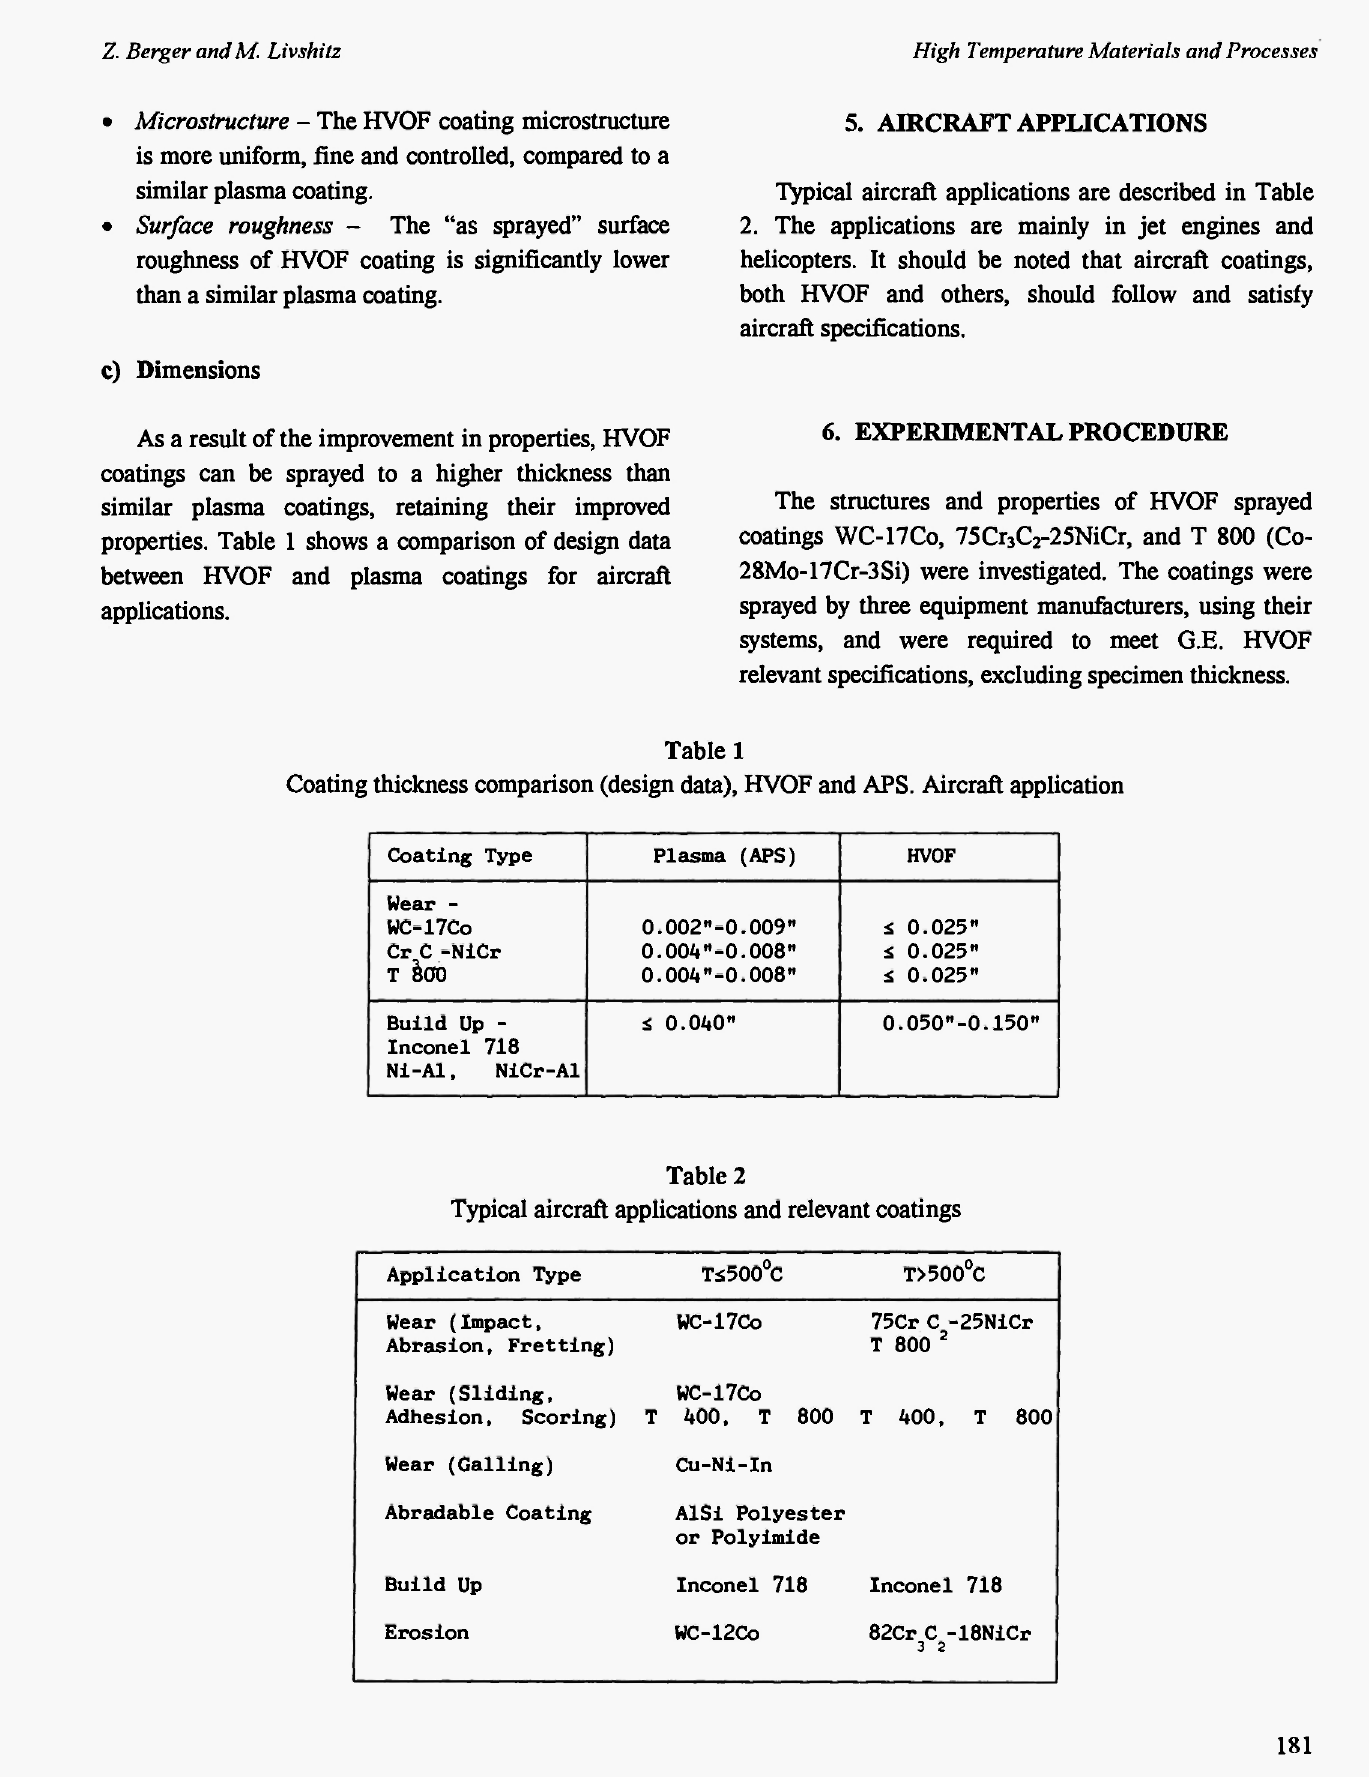
Typical aircraft applications and relevant